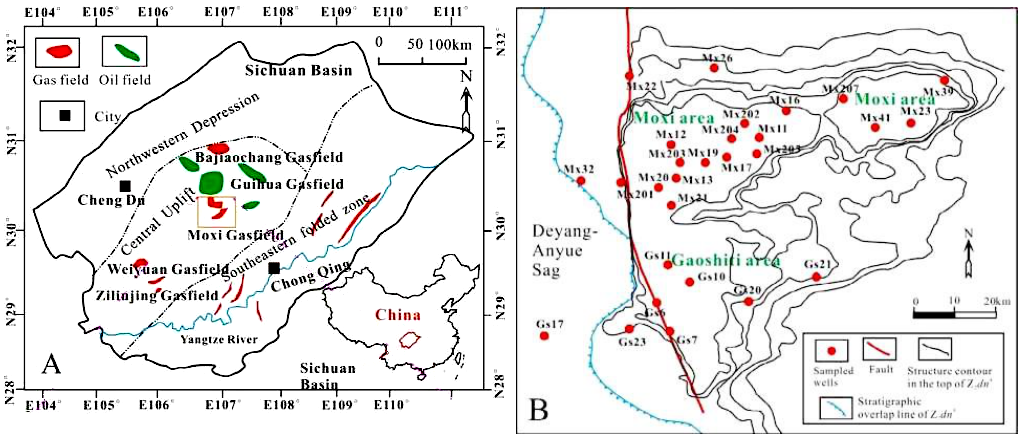
Figure 1. Location of the Gaoshiti–Longnusi area: ( A ) Sichuan Basin; ( B ) Longwangmiao carbonate gas reservoir [17,45].